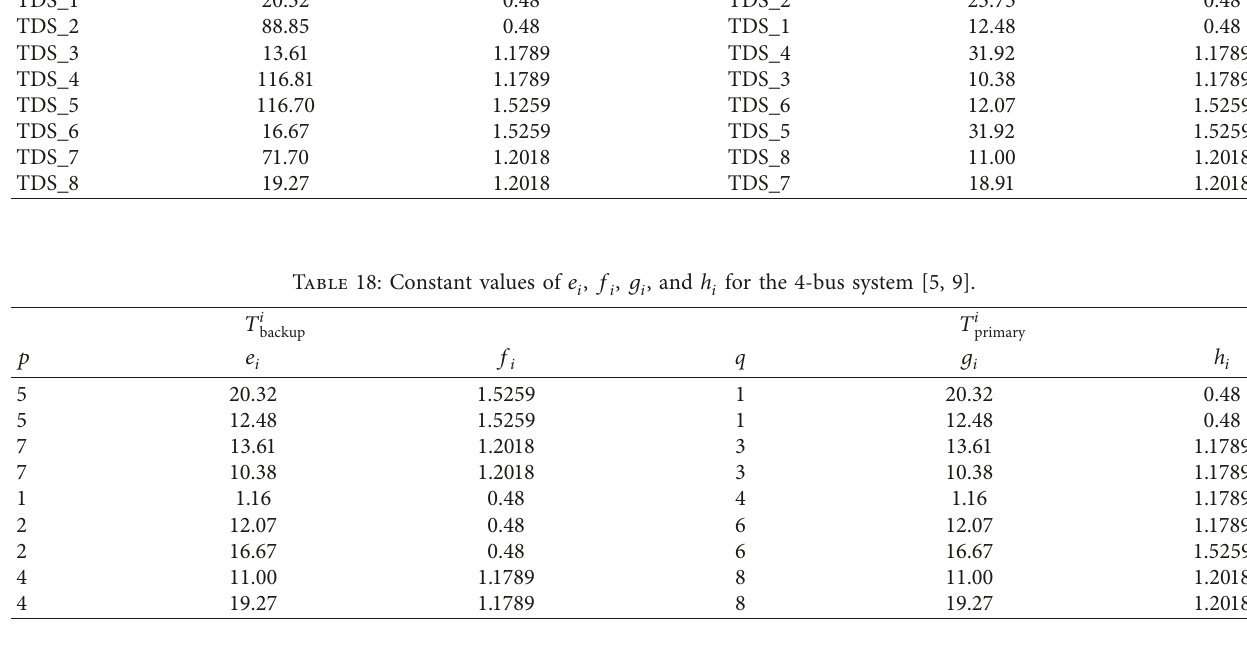
Table 17: Constant values of a